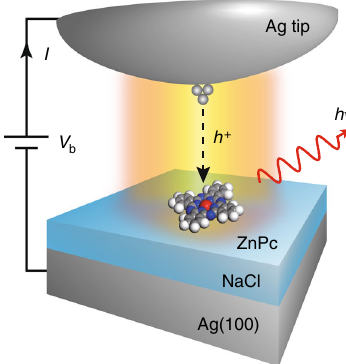
Fig. 1 Schematic diagram of STM-induced fl uorescence from a single molecule. Molecular fl uorescence is generated by the excitation of highly localized tunneling electrons over a single ZnPc molecule that is decoupled by NaCl layers from the Ag(100)